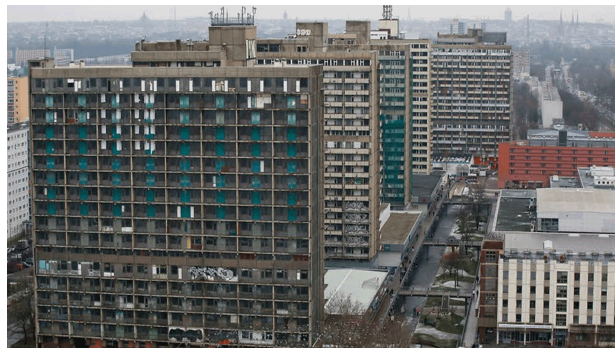
Fig. 1 . Image of the Halle-Newtown case study area. Most